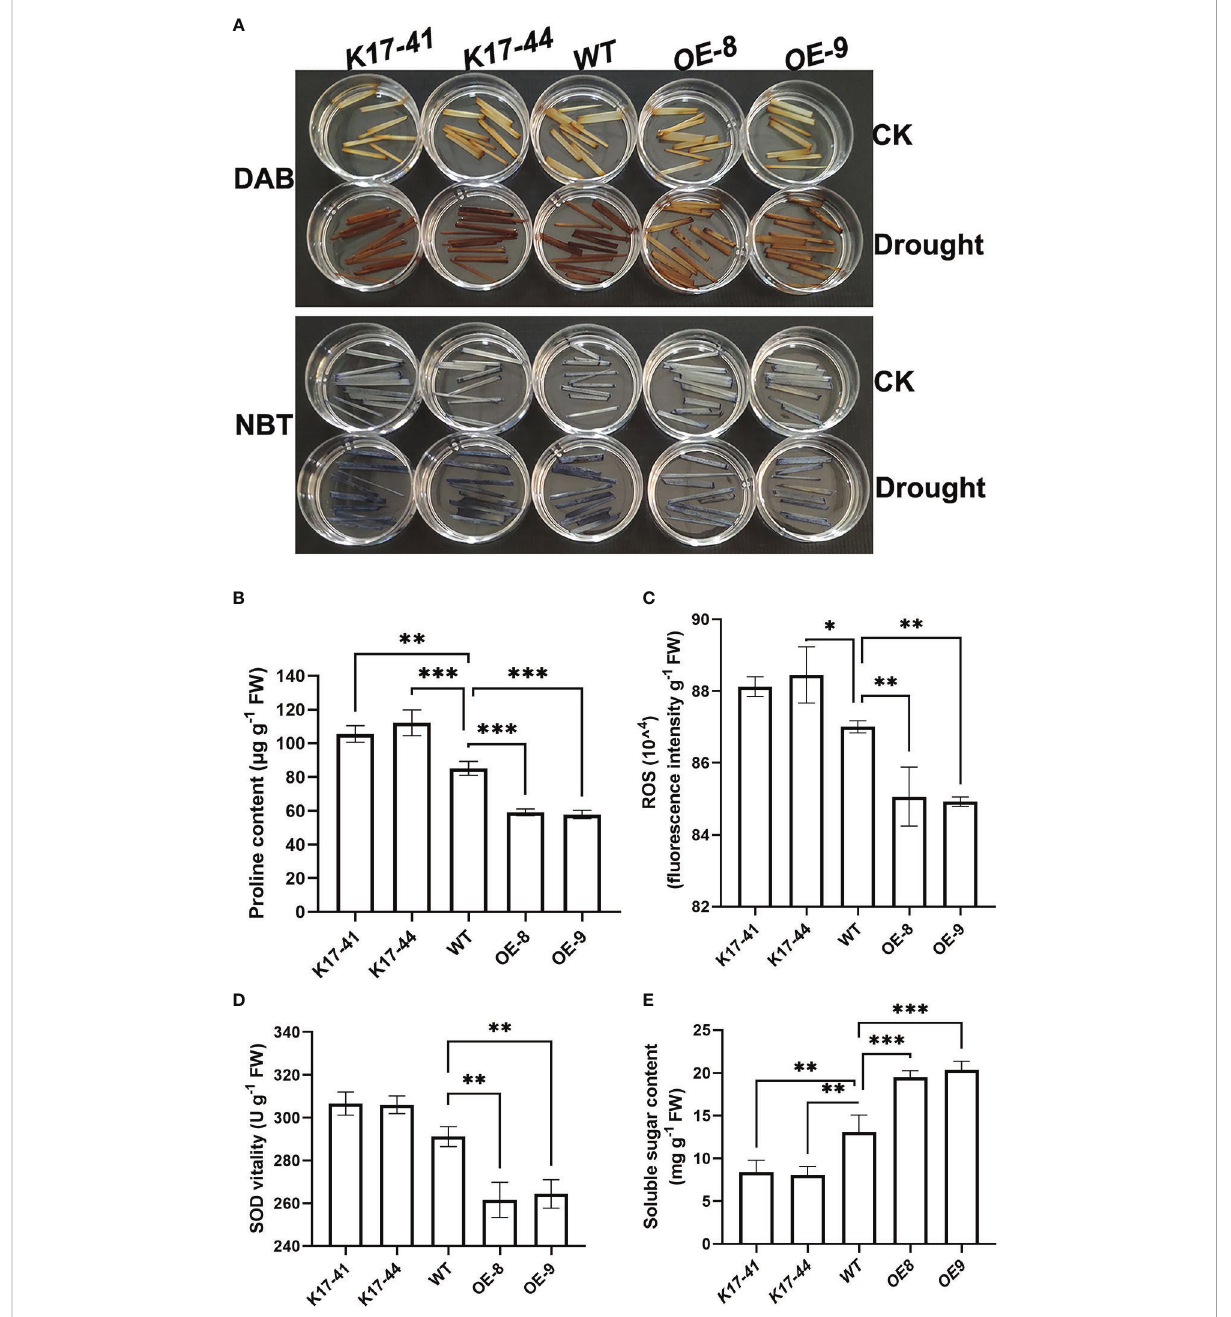
FIGURE 2 Drought-induced changes in proline, soluble sugar, and ROS levels and SOD activity in OsCIPK17 -OE and OsCIPK17 -Mutant plants. (A) In situ detection of H 2 O 2 and superoxide anion in leaves using DAB and NBT staining, respectively. (B) Proline content, (C) ROS content, (D) SOD activity. (E) Soluble sugar content. Leaf samples were collected from 3-week-old OsCIPK17 -OE, OsCIPK17 -Mutant, and WT plants grown under normal water or drought conditions (at 5 days after water withholding) and subjected to physiological measurements. Data in (B – E) are presented as mean ± SD of three independent experiments, and signi fi cant differences between OsCIPK17 -OE/ OsCIPK17 -Mutant and WT plants according to one-way ANOVA are indicated by asterisks. Asterisks indicate signi fi cance (*p < 0.05, **p < 0.01, ***p <